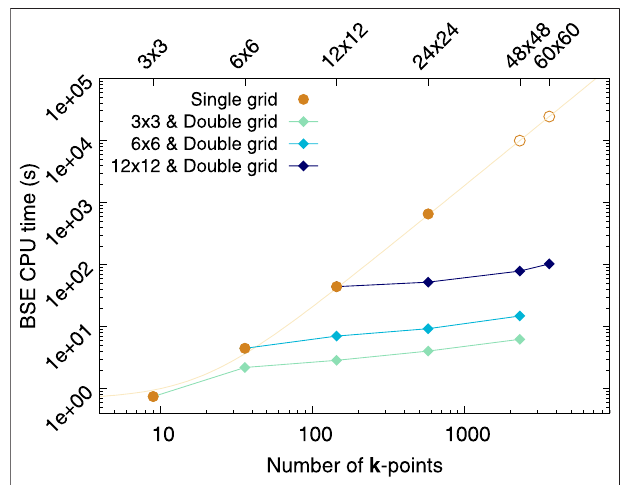
FIGURE 4 | CPU time in seconds required to calculate and store the BSE kernel, and solve it via Haydock ’ s iterative scheme as a function of the numberof k -points.Browncirclesrepresent full BSEcalculations.Thedatafor 48 × 48 × 1and 60 × 60 × 1 k -grids have been estimated viaaquadratic fi tting. The diamonds denote double-grid BSE calculations. Lines connect double-grid calculations using the same coarse-grid. All calculations were carriedoutinoneprocessorforcomparabilitypurposes.Thedataplottedhere corresponds tomonolayerMoS 2 .We consider all e − h pairs from thetop three valence bands to the fi ve bottom conduction